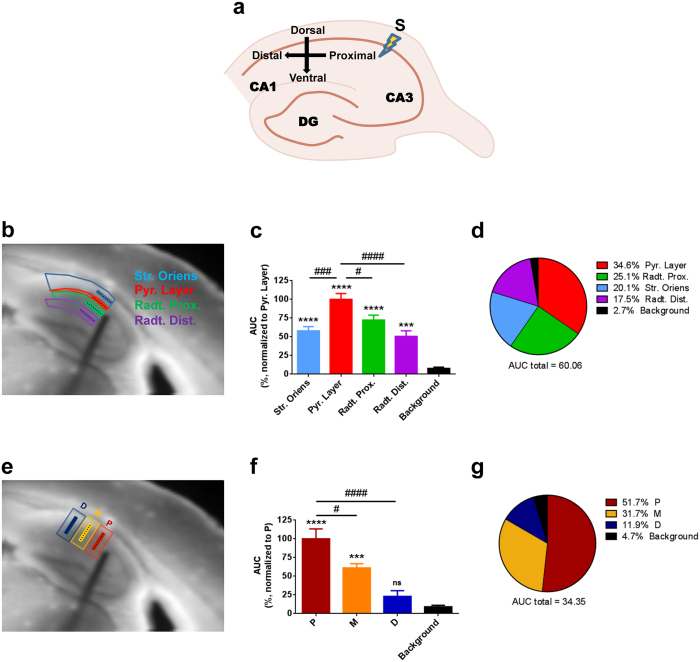
Spatial distribution of VSDI-recorded fIPSPs throughout CA1 region.(a) Cartoon representing the orientation of the different sub-regions studied in the CA1 (S, stimulation electrode). (b) Scheme showing spatial organization of the 8 pixels long ROI lines inside the dorso-ventral axis of CA1 (reference CA1 sub-regions are delimited by the colored contour). (c) Quantification through AUC of hyperpolarization from the ROI lines shows detectable signal in all the dorso-ventral regions of CA1, which is mainly localized in the pyramidal layer (one-way ANOVA followed by Tukey post-hoc test; asterisks are differences vs. “Background”, while hashes are differences vs. “Pyramidal layer”). (d) Pie chart summarizing the distribution of the signal from the lines along the dorso-ventral part of CA1 showing a predominant presence in the pyramidal layer (percentage of each region respect to the total AUC). (e) Scheme showing spatial organization of the 8 pixels long ROI lines inside the proximo-distal axis of CA1 (reference proximo-distal ROIs are delimited by the colored contour); “P” = proximal, “M” = medial, “D” = distal; distances from stimulation electrode are ~106, ~318 and ~531 μm for regions P, M and D respectively. (f) Quantification through AUC of hyperpolarization from the ROI lines shows detectable signal at the proximity of the stimulation electrode (lines in regions “P” and “M”) while signal from lines in region “D” is not different from background (one-way ANOVA followed by Tukey post-hoc test; asterisks are differences vs. “Background”, while hashes are differences vs. “P”). (g) Pie chart summarizing how the signal from the ROI lines along the proximo-distal part of CA1 is concentrated in the proximity of the stimulation electrode (percentage of each region respect to the total AUC). n = 10 slices from 10 mice. Data are mean ± s.e.m. #p < 0.05, ### and ***p < 0.001, #### and ****p < 0.0001, ns = not significant.